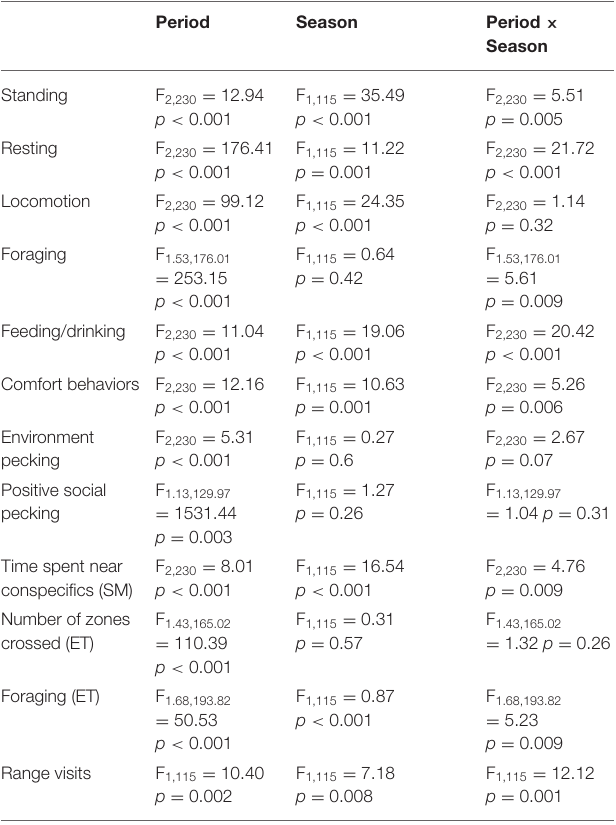
TABLE 2 | Statistics on the effects of period, season, and their interactions on the mean-level expression of behaviors of free-range chicken in their home environment and in the individual tests (social motivation, SM, and exploration tests,